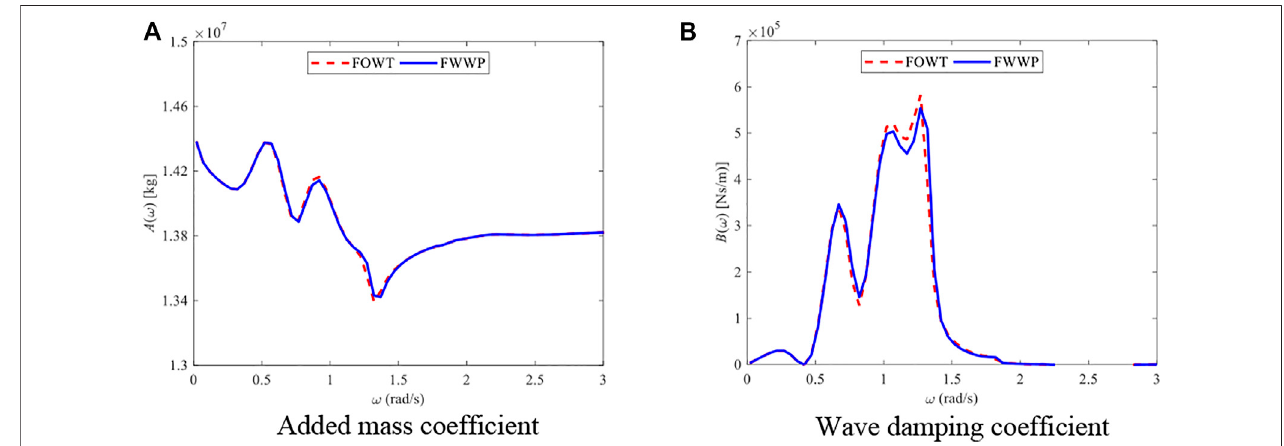
FIGURE 4 | The comparison of heave radiation coef fi cients for the platform. (A) Added mass coef fi cient. (B) Wave damping coef fi cient.